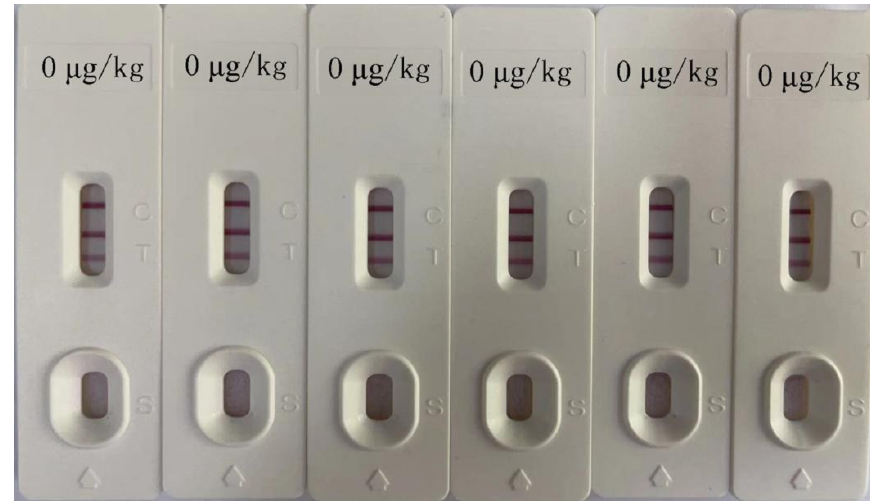
Figure 5. Test strip repeatability test results.